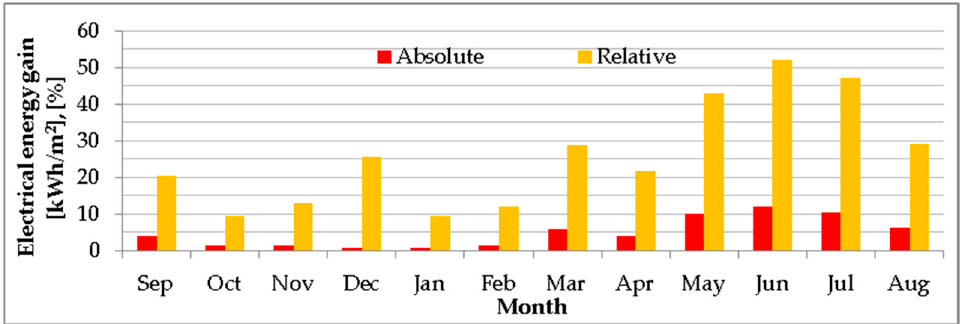
Figure 10. Absolute and relative monthly electrical energy gain of the tracked vs fixed PV platform.